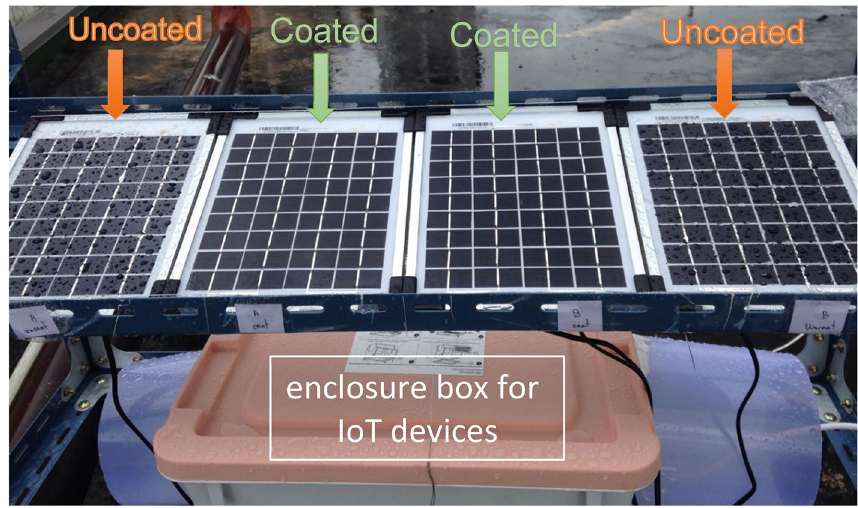
Figure 12. Picture of the uncoated and coated PV panels after rain.